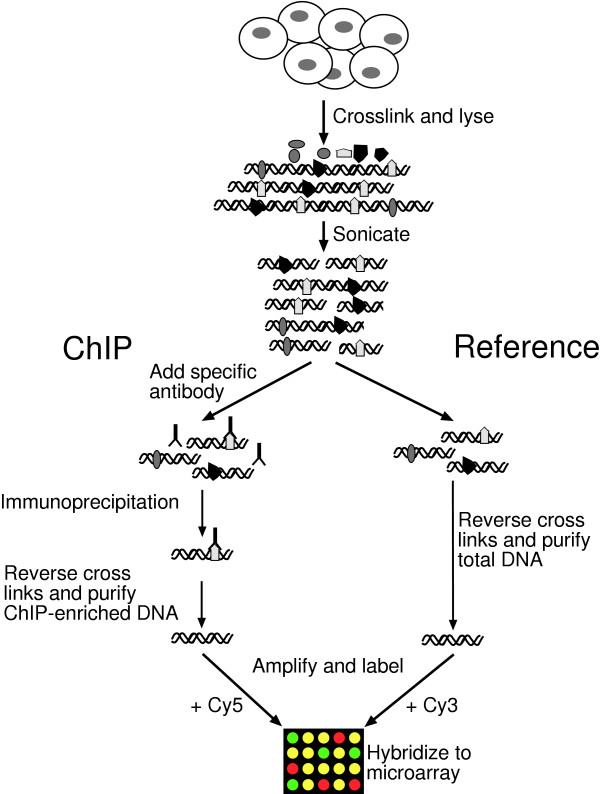
A summary of the ChIP-chip procedure. See the text for details.